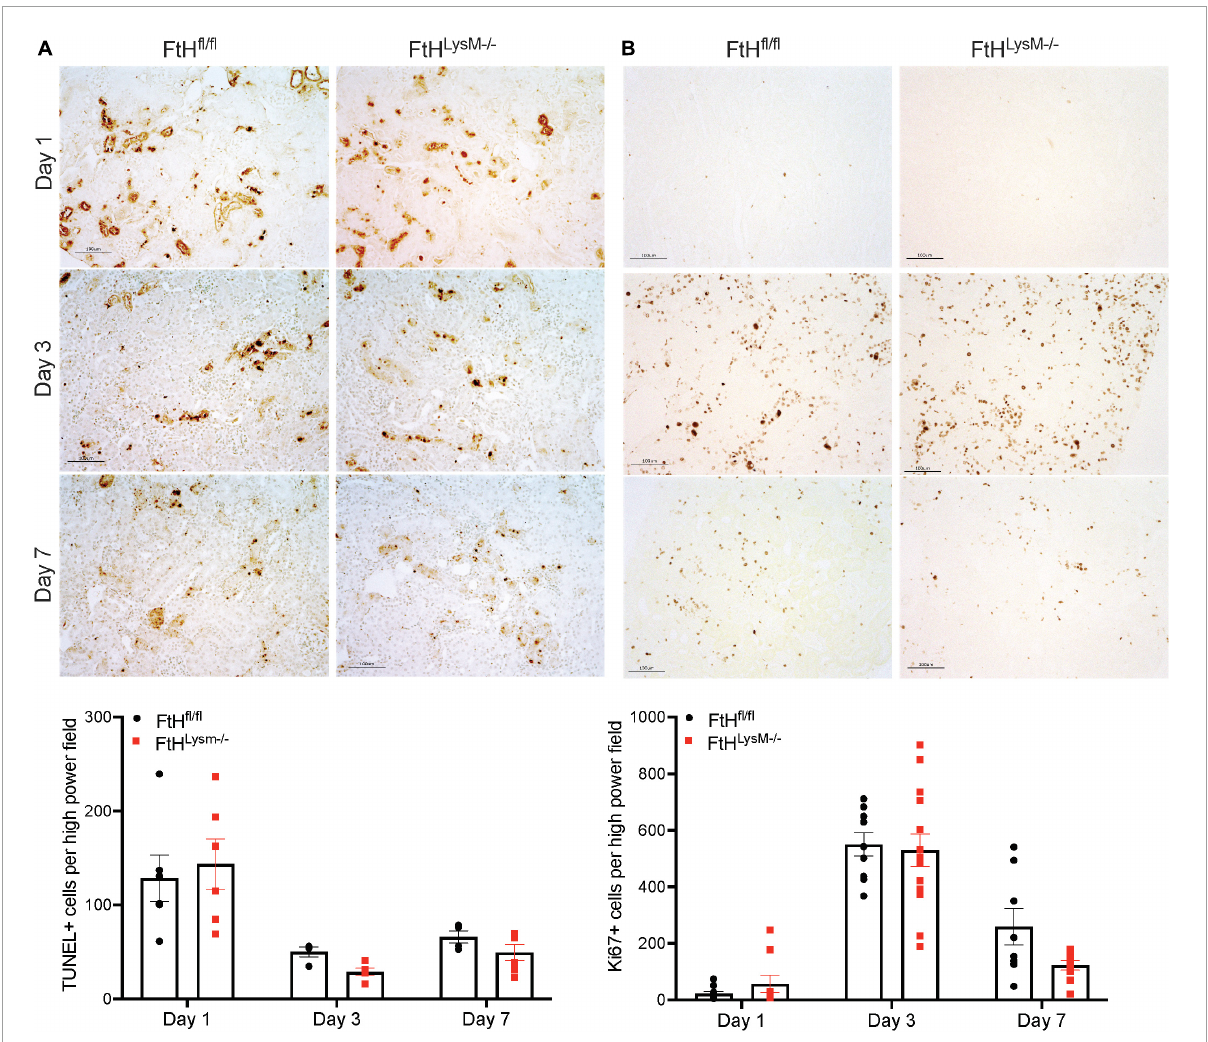
FIGURE4 Cell death and proliferation in rhabdomyolysis-AKI. (A) Representative images of kidney sections in the TUNEL assay from FtH fl / fl and FtH LysM − / - mice after 1-, 3-, or 7-days post-glycerol administration. Brown puncta represents TUNEL positive nuclei. Scale bar represents 100 µ m. (B) Representative images of kidney sections immunostained with Ki67 antibody from FtH fl / fl and FtH LysM − / - mice after 1-, 3-, or 7-days post-glycerol administration. Brown puncta represents Ki67 positive nuclei. Scale bar represents 100 µ m. Quantification of TUNEL- and Ki67-positive cells, respectively, are shown in the graphs. To quantify, 5–10 high power field images were obtained, and stained nuclei were quantified, and a mean value was obtained for each animal. Group means ± SEM were then calculated and presented in the